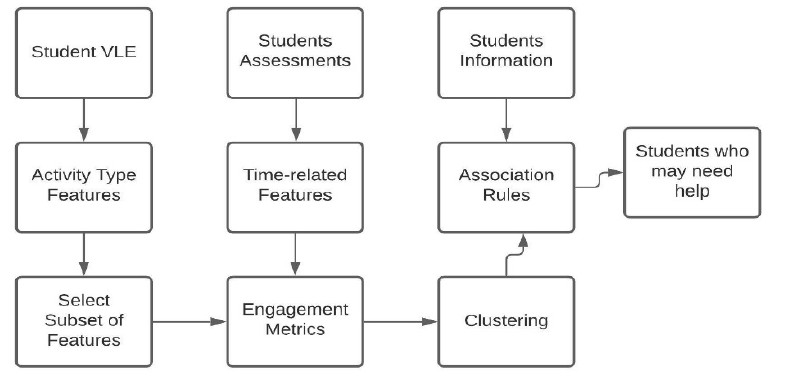
Figure 3. Proposed VLE analytical model.